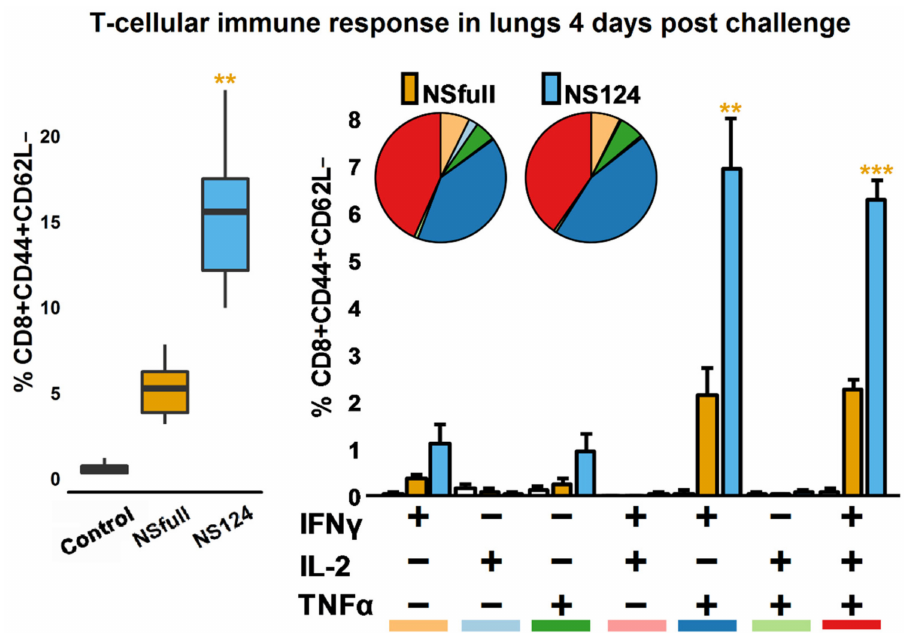
Figure 4. CD8 + T-cellular response in mice immunized with the A/PR8/NSfull or A/PR8/NS124 influenza strain after the challenge with A/Aichi/2/68. Box plots represent the total percentage of cytokine-producing effector memory CD8 + CD44 + CD62L − T-lymphocytes after 6 h of in vitro lung or spleen cells stimulation with the NP 366-374 peptide 4 d.p.c. Histograms represent the per- centage of different populations of cytokine-producing T-cells in the total effector memory (EM) CD8 + CD44 + CD62L − T-lymphocytes population. Pie charts represent the percentage of cells produc- ing any combination of IFN γ , IL2, or TNF α cytokines in the total cytokine-producing CD8 + EM T-cell subset. Color bars under histogram mark different cytokine-producing populations and correspond to the pie chart color scheme. Groups were compared using ANOVA followed by Tukey’s post-hoc test (**: p < 0.001, ***: p < 0.0001, n =